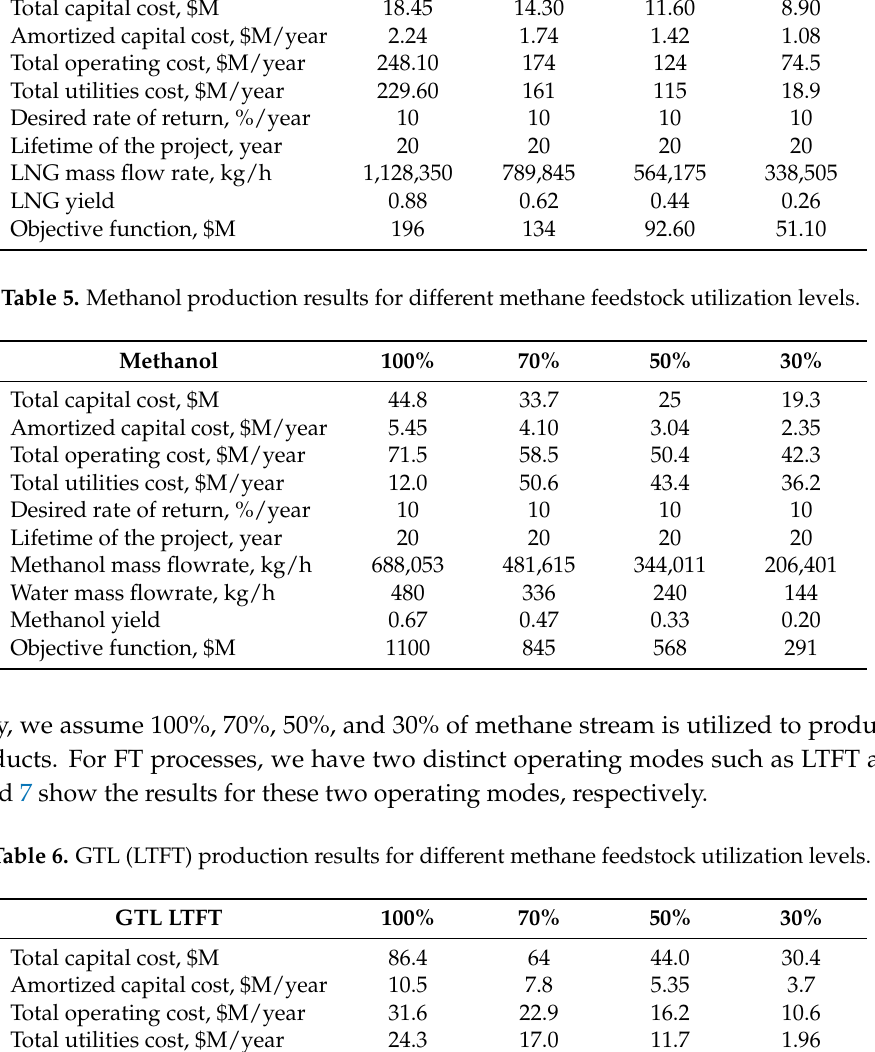
Table 4. LNG production results for different methane feedstock utilization levels. LNG